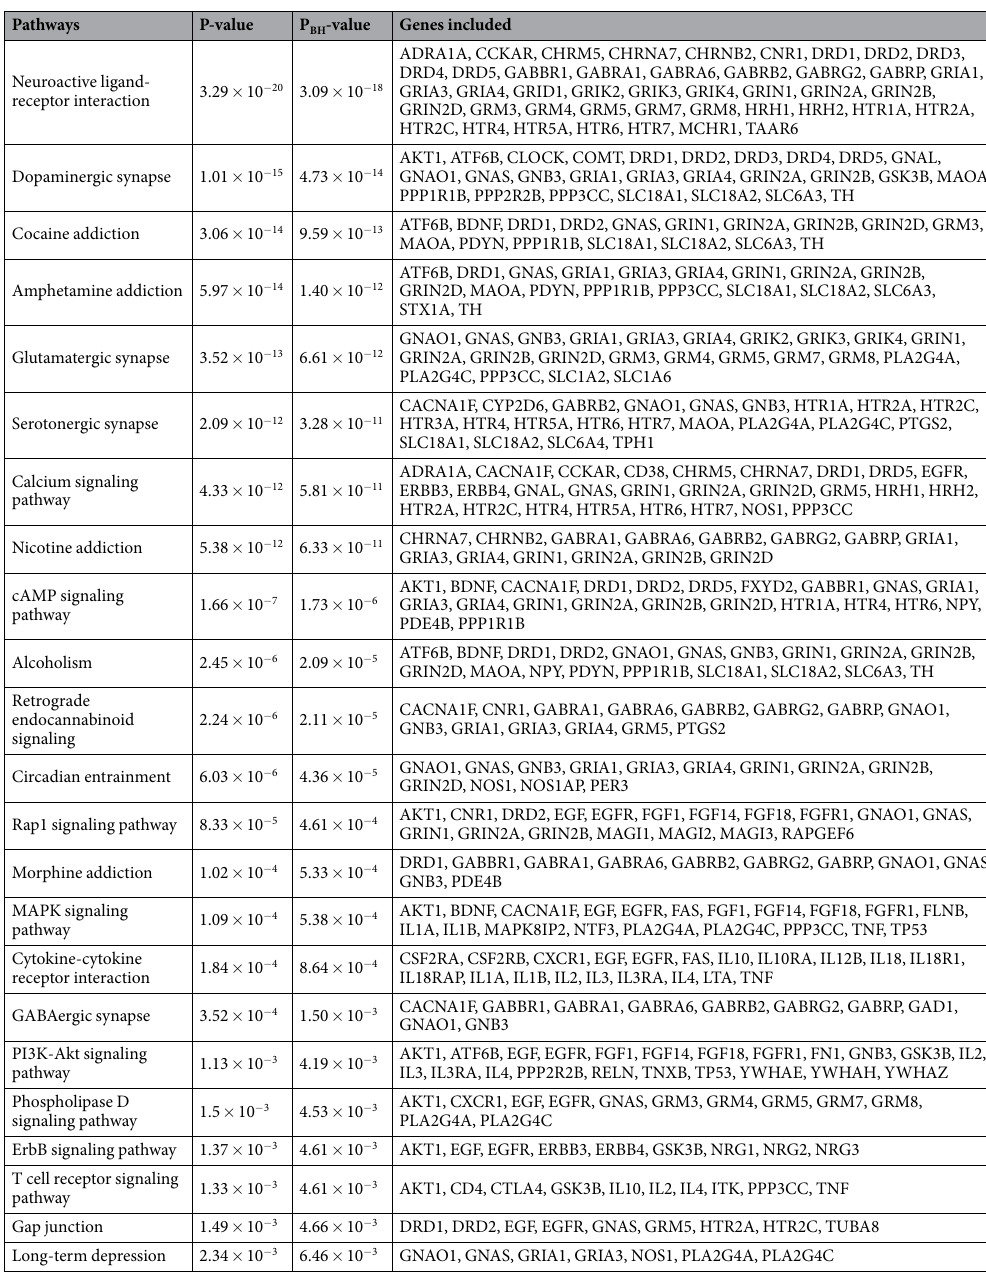
Table 2. Pathways Enriched by Genes Associated with